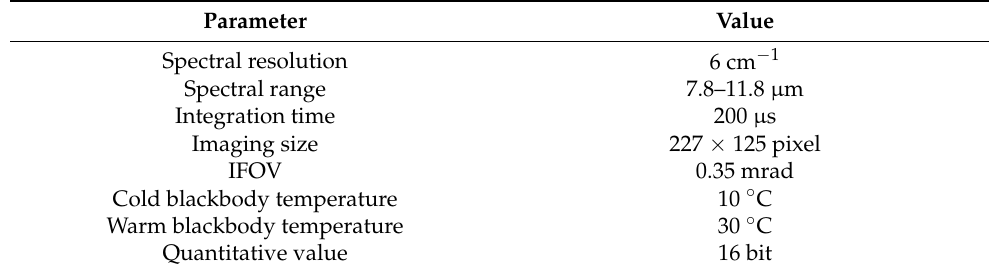
Table 1. Basic specifications and configuration of the Hyper-Cam LW sensor for field-based TIR hyperspectral imagery acquisition.